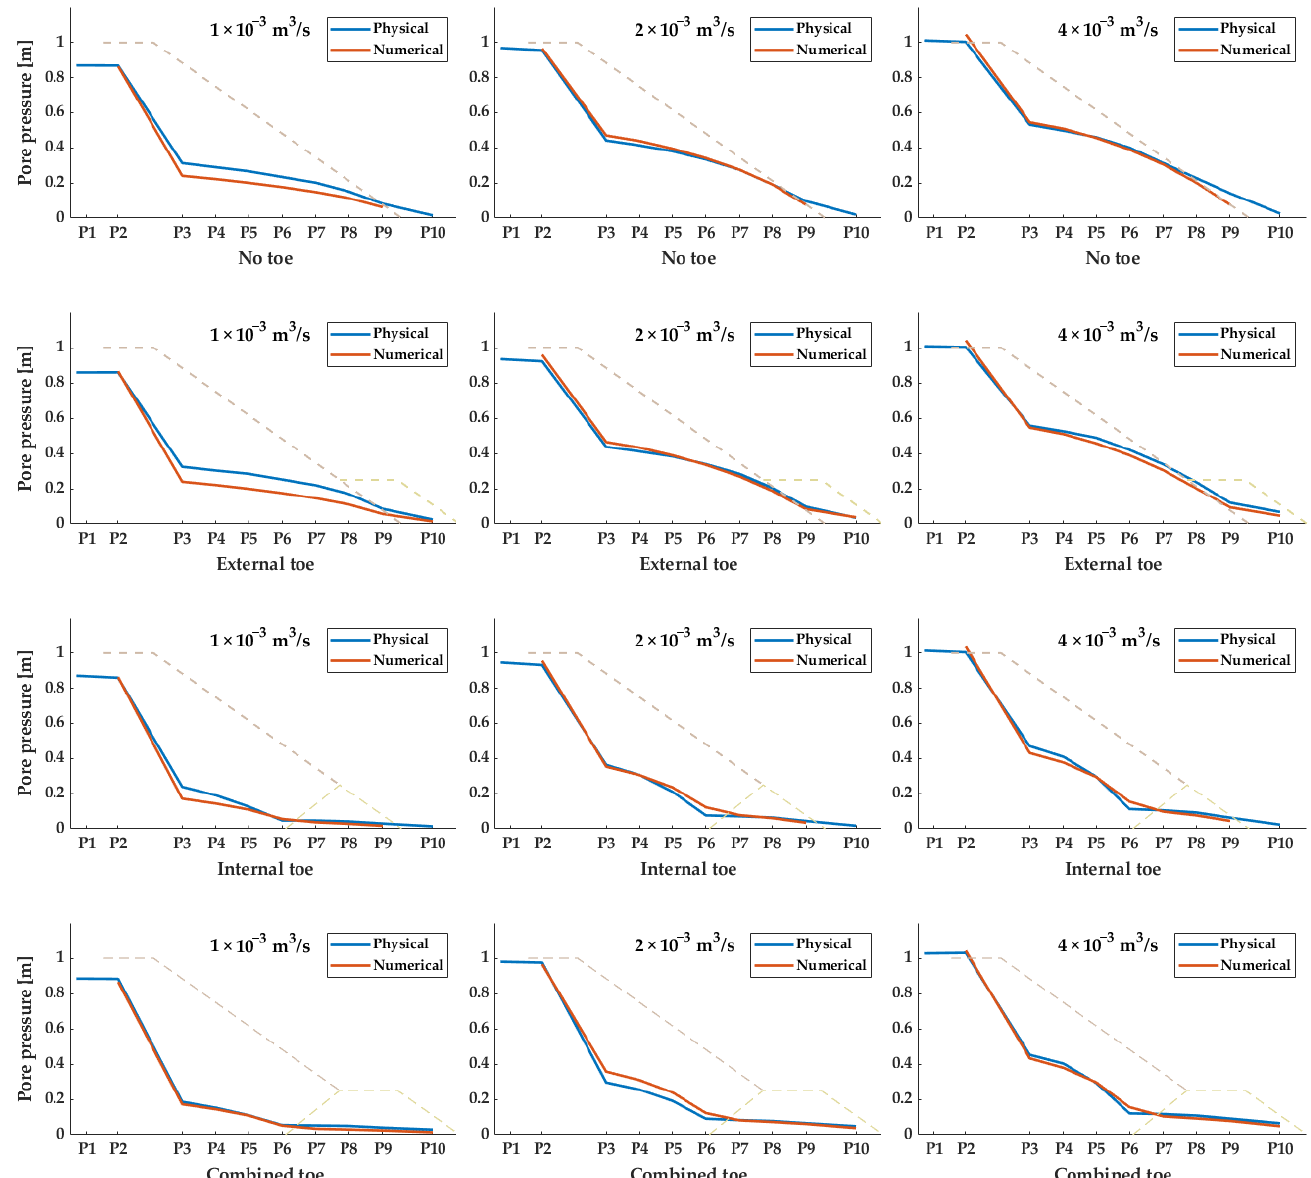
Figure 10. Numerical modeling results juxtaposed to physical modeling results. The stippled line displays the outline of the dam and toe